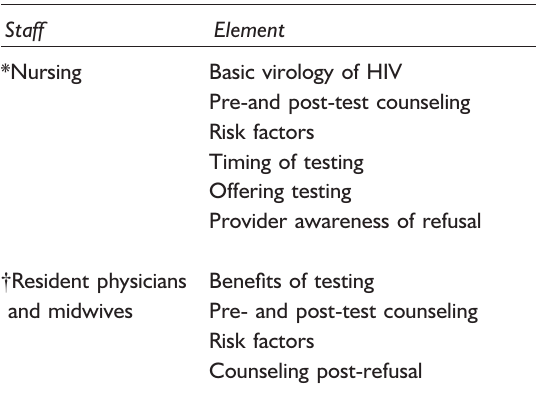
Table 1 Key elements of staff education